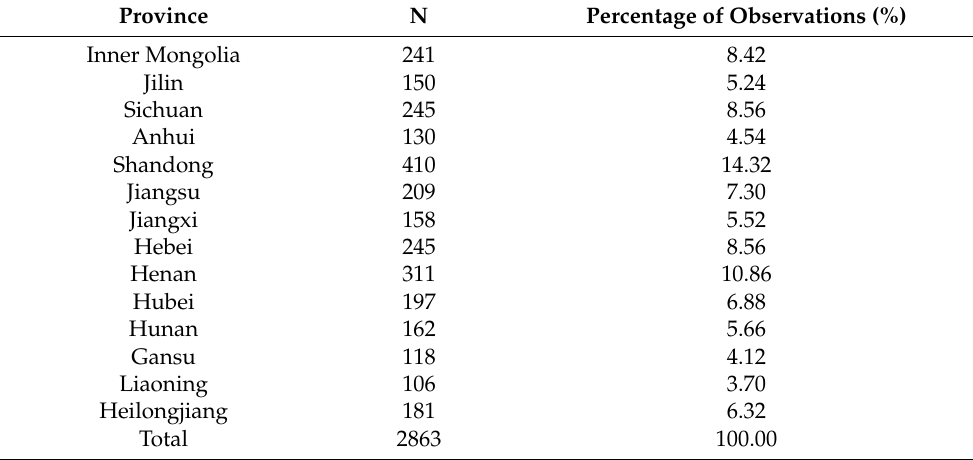
Table 1. Distribution of observations by province/autonomous